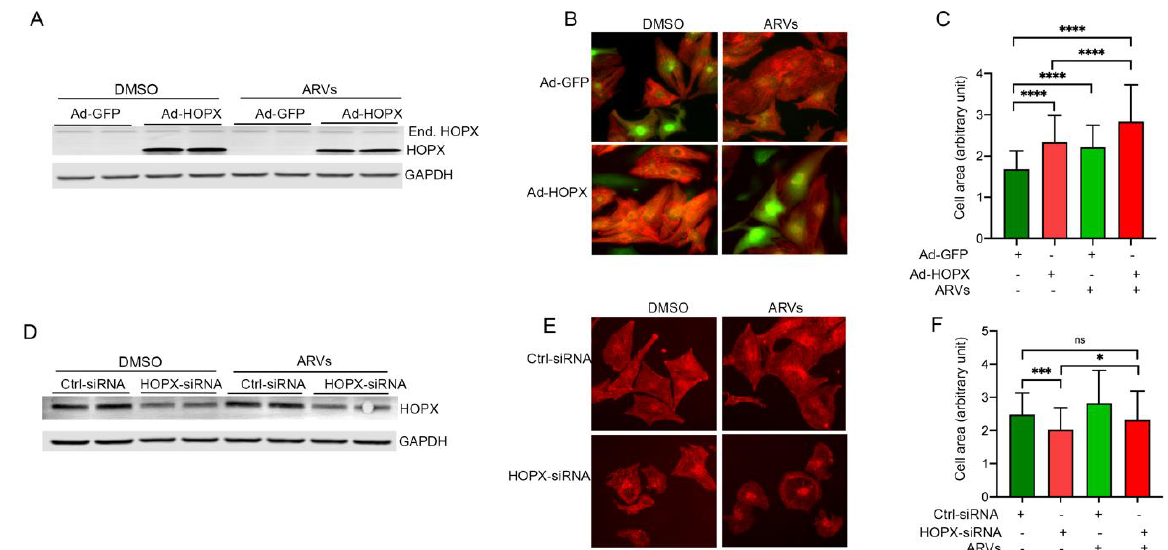
Figure 4. HOPX regulates ARV-induced cardiomyocytes hypertrophy. NRVCs were infected with HOPX adenovirus and treated with ARVs or DMSO for 24 h. Cardiomyocytes infected with Ad-GFP were used as control cells. ( A ) Western blot image showing HOPX protein expression in adenovirus-treated cardiomyocytes. ( B ) NRVCs were infected with Ad-HOPX or Ad-GFP and incubated for 48 h, and then treated with ARVs or DMSO for 24 h. Cells were fixed with 4% PFA and immunocytochemistry was performed with actinin antibody, and nuclei were counterstained with DAPI. Representative microscopy images showing cardiomyocytes after Ad-HOPX and ARVs treatment. ( C ) The graph shows the quantification of cardiomyocyte cell size. Cell size was determined using ImageJ software (n = 100). To knockdown the expression of HOPX in cardiomyocytes, NRVCs were treated with HOPX-siRNA or control-siRNA for 24 h, and then cells were treated with ARVs or DMSO for 24 h. Proteins were isolated for the Western blot, or cells were fixed for the microscopy. ( D ) Western blot images show a decrease in HOPX expression level in HOPX-siRNA transfected cells compared to control siRNA. ( E ) Representative microscopy images show cardiomyocytes treated with HOPX-siRNA and ARVs. Cells were stained with actinin antibody. ( F ) The graph shows the quantification of cardiomyocyte cell size. Cell size was measured using Image J software (n = 100). ( p -value = ns, not significant; *, <0.05; ***, <0.001; ****, <0.0001).